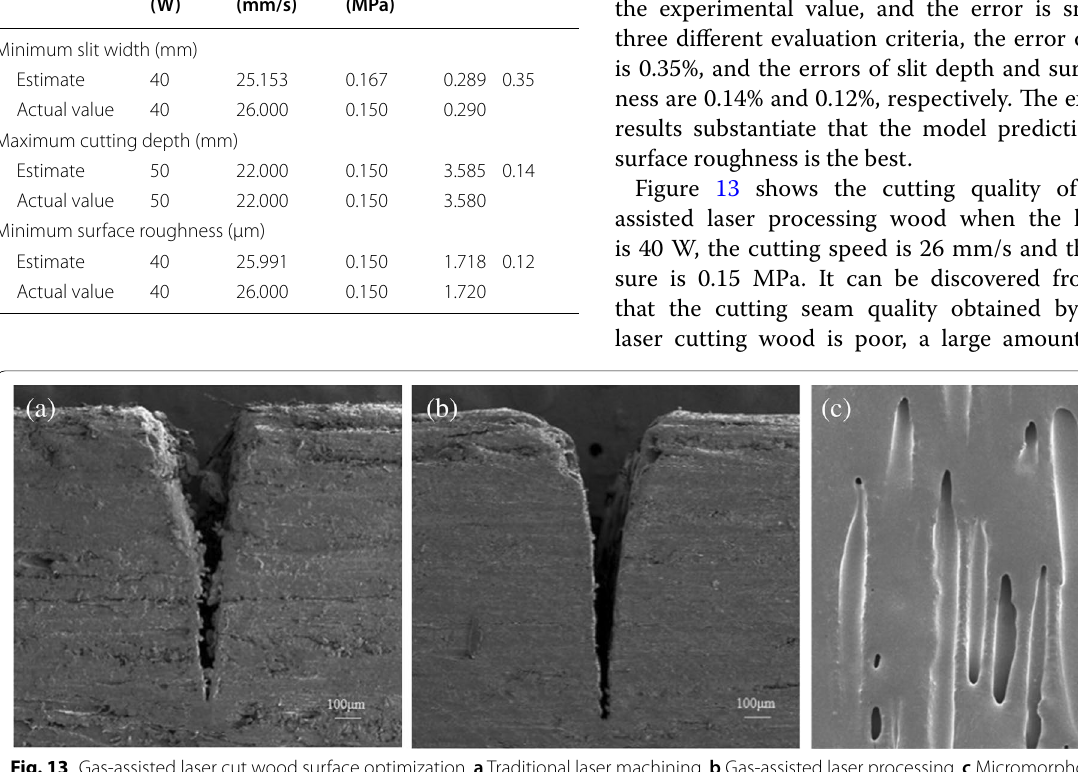
Table 8 Selection and verification of model process parameters Evaluation criterion